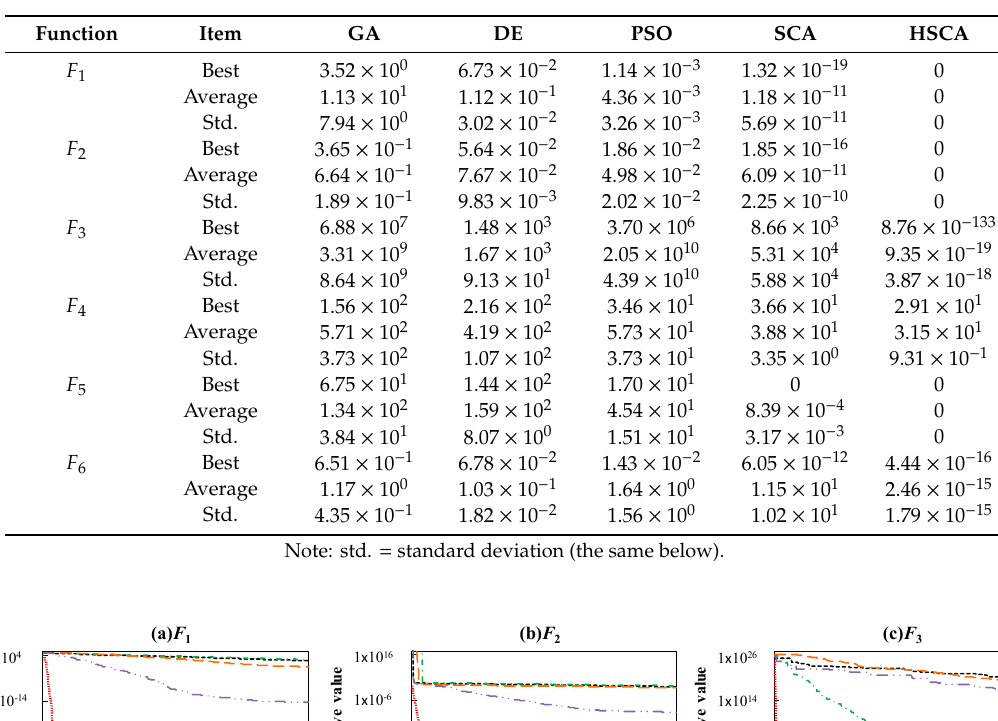
Table 3. Experimental results of di ff erent methods for test functions in 40 variables.